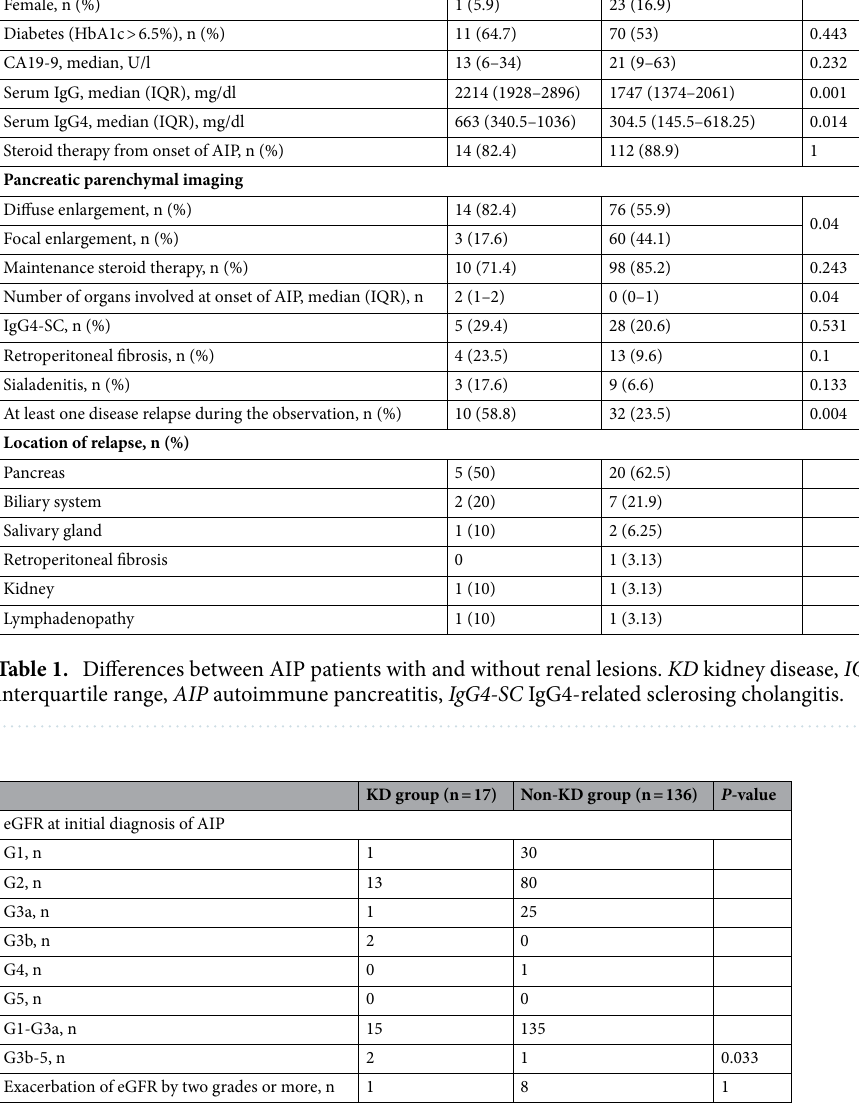
Table 2. Differences in renal function between the KD and non-KD groups. eGFR estimated glomerular filtration